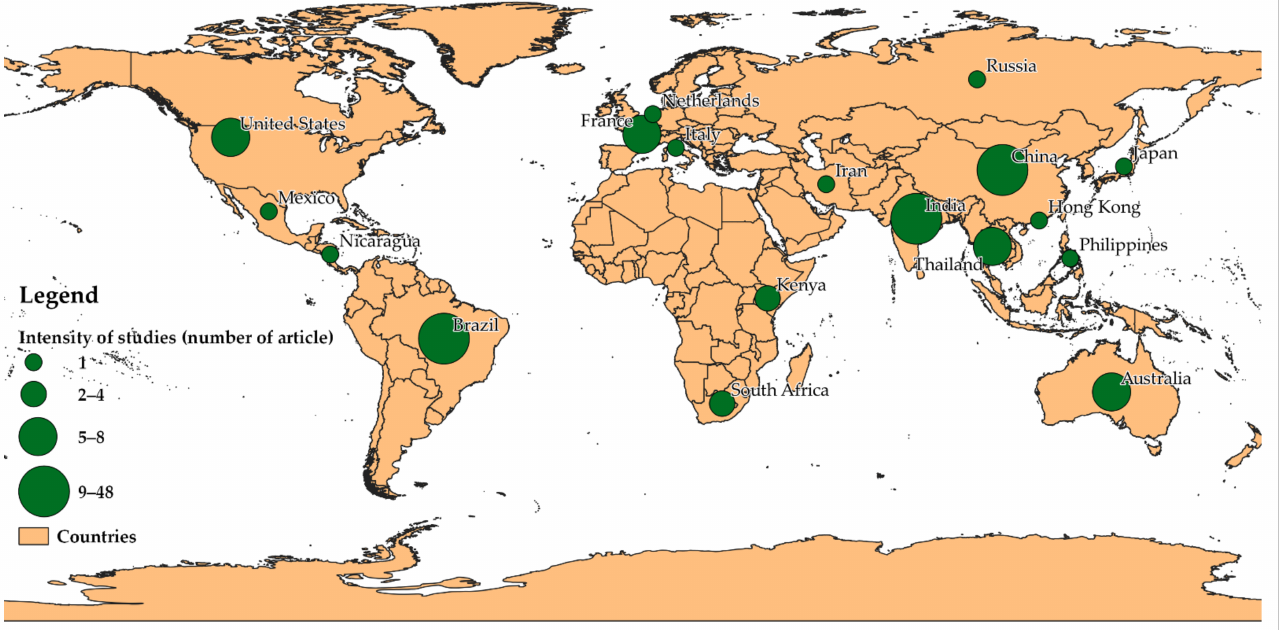
Figure 12. Regional distribution of the analyzed all publications by country in the period 1981 to 2020 based on affiliation of the first